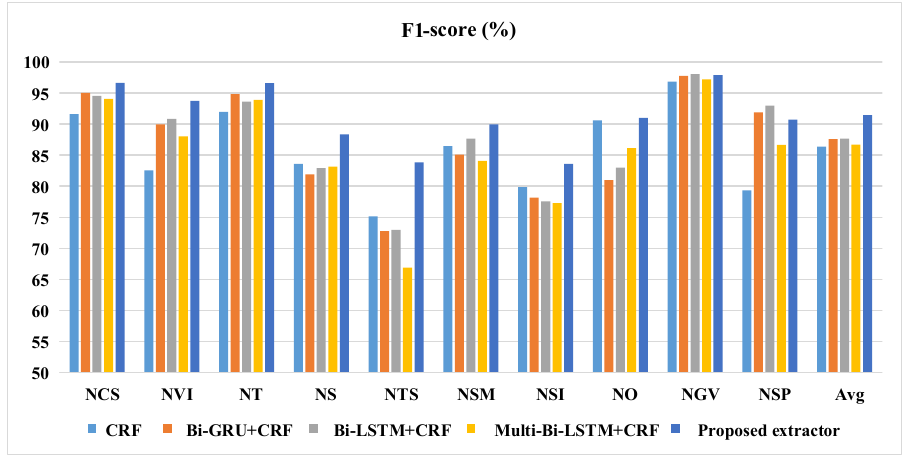
Figure 8. F1-score performance of the deep learning-driven extractor and baselines in each cate-